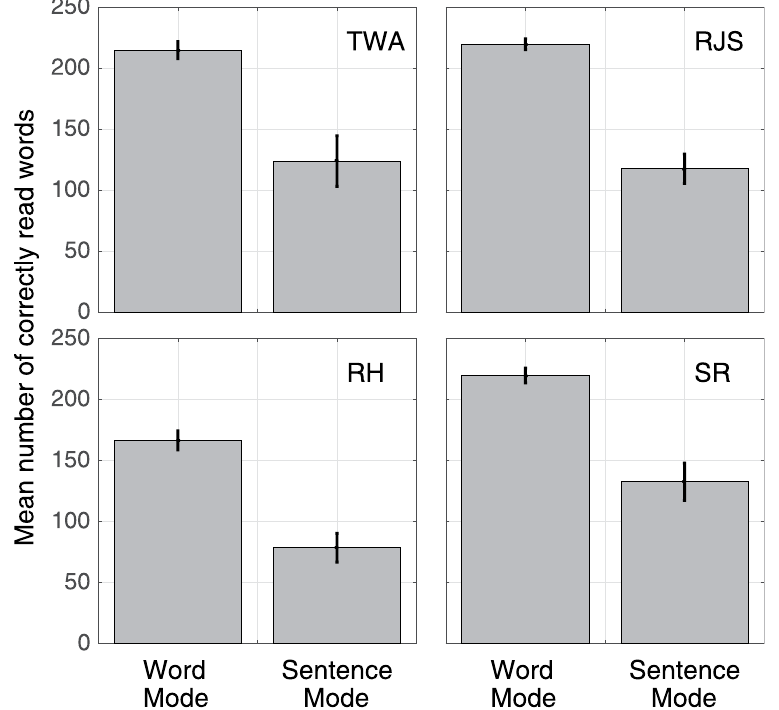
Figure 2. Reading accuracy for Word Mode and Sentence Mode, showing the mean number of correctly read words for all text sizes less than 1.0 logMAR, averaged across four observers. An accuracy of 100% is equivalent to 250 correctly read words. The vertical error bars show ± 84% confidence intervals.